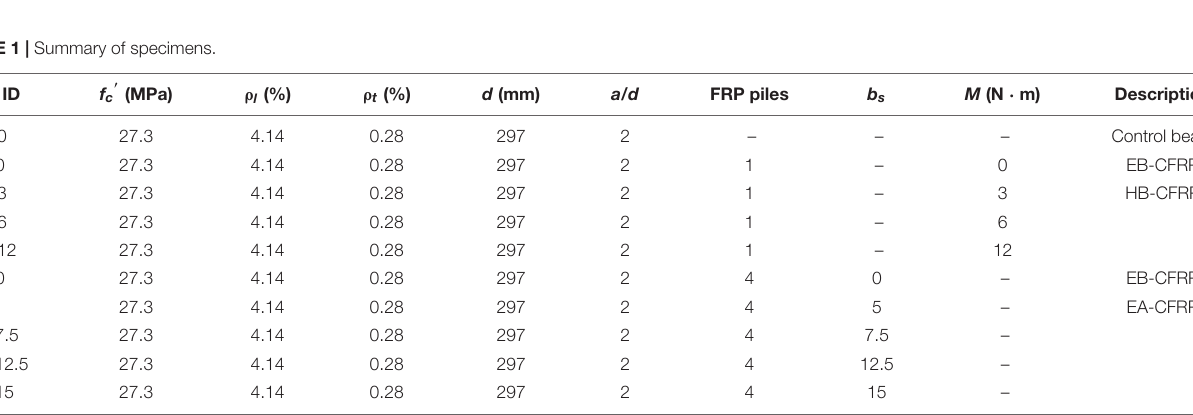
TABLE 1 | Summary of